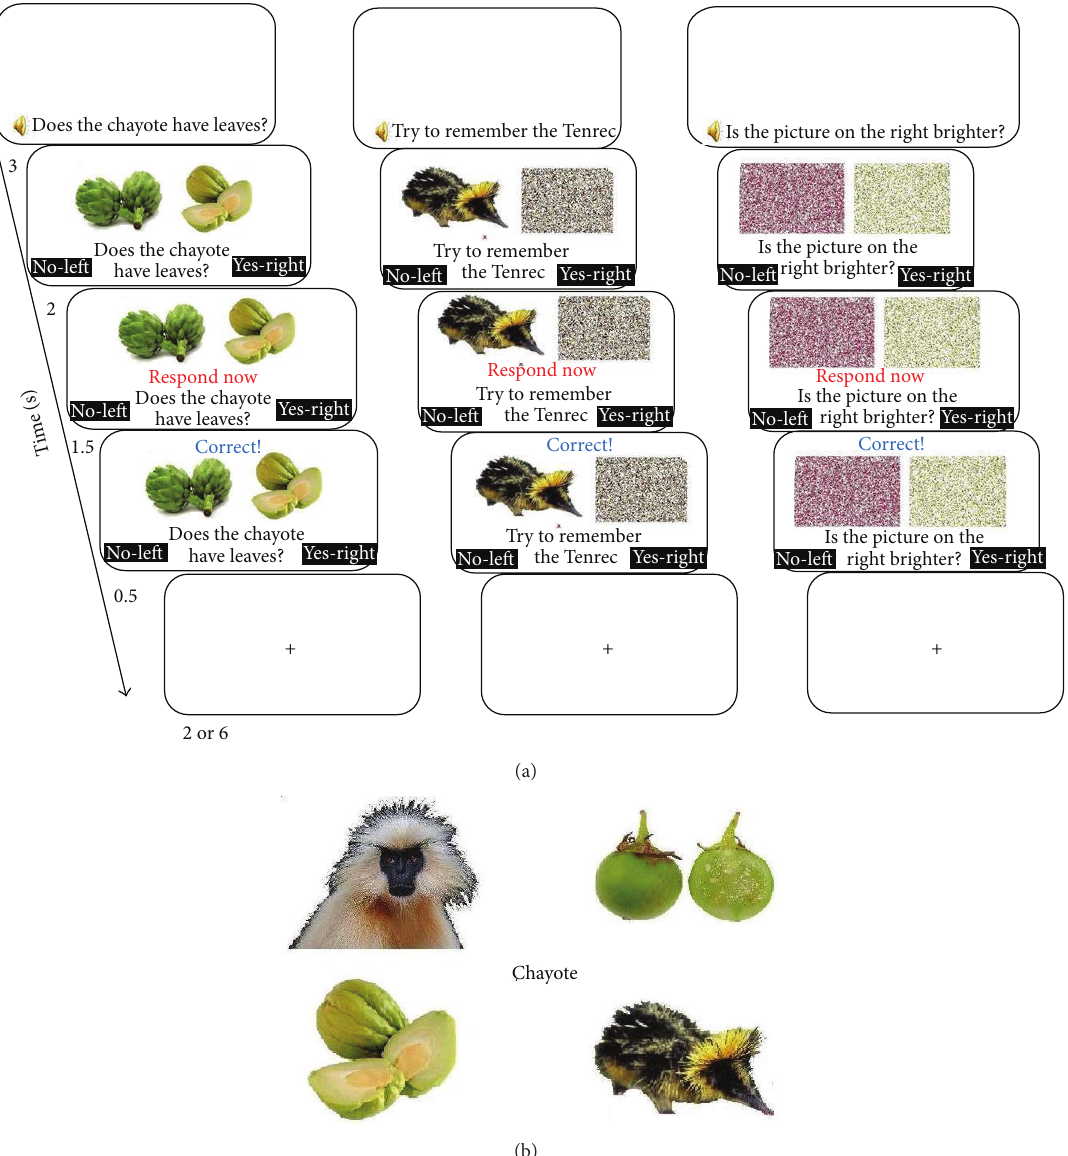
Figure 1: (a) Examples of single trials for FM (left), EE (middle), and baseline (right) stimuli; not to scale. (b) A single retrieval trial (note: EE and FM retrieval trials are